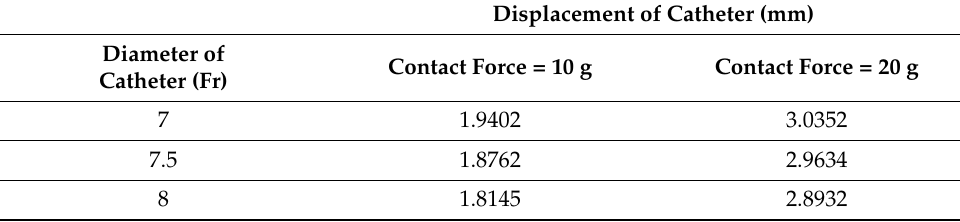
Table 2. Displacement of the catheter